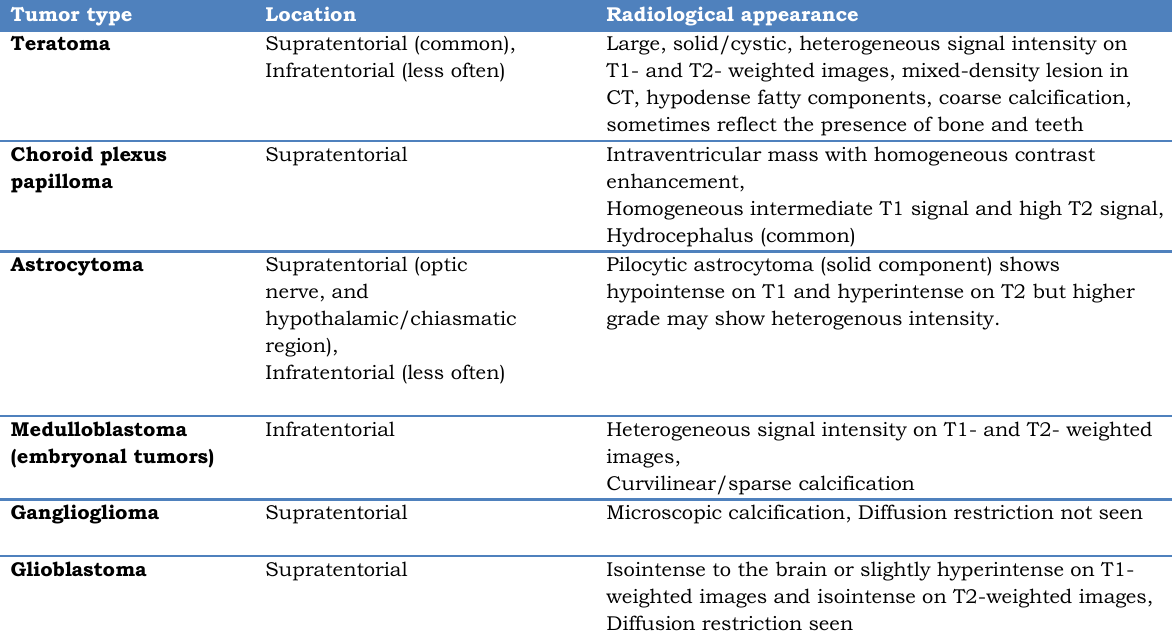
Table 1: radiological features of common neonatal brain tumors [21,